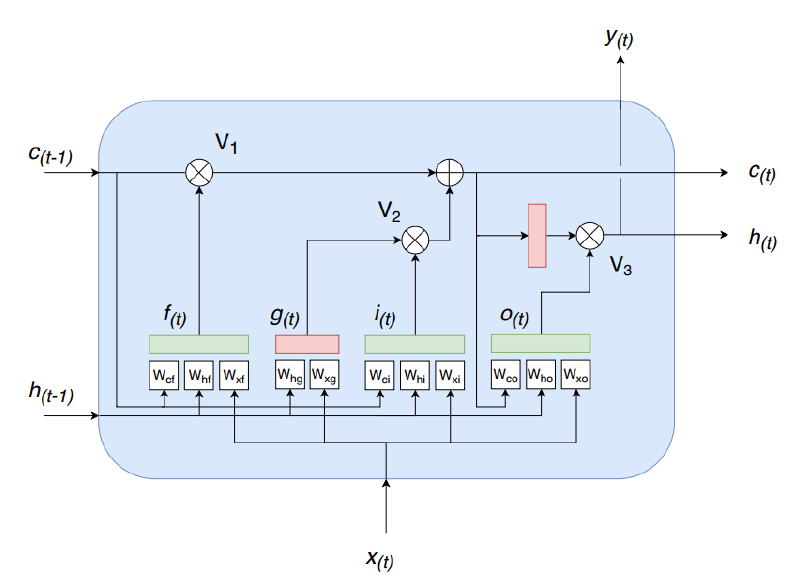
( i ) is processed by t